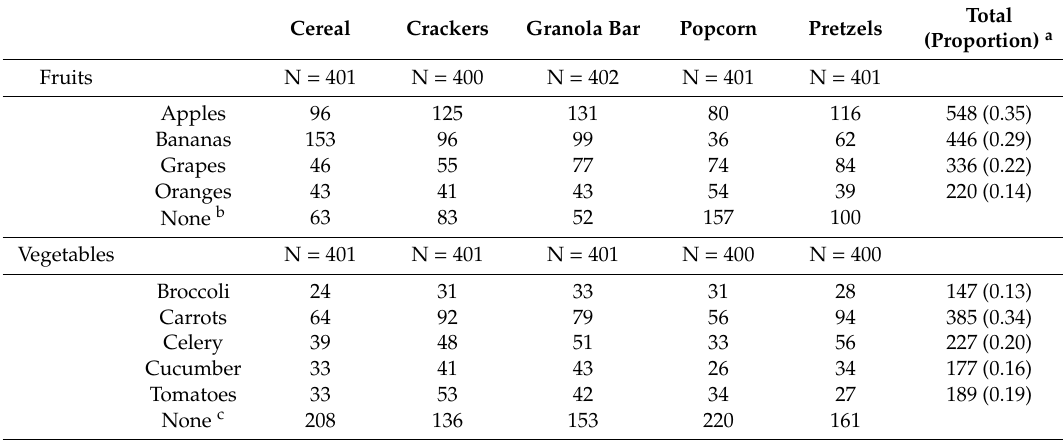
Table 3. The frequency and proportion of surveyed youth who visited a City Harvest Healthy Retail Program corner store during the one-time store visit who indicated which vegetables and fruits, if any, paired best with whole grain snacks.